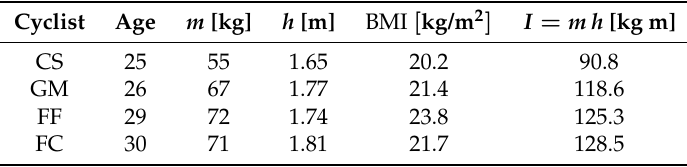
Table 2. Anthropometric data of tested competitive cyclists.